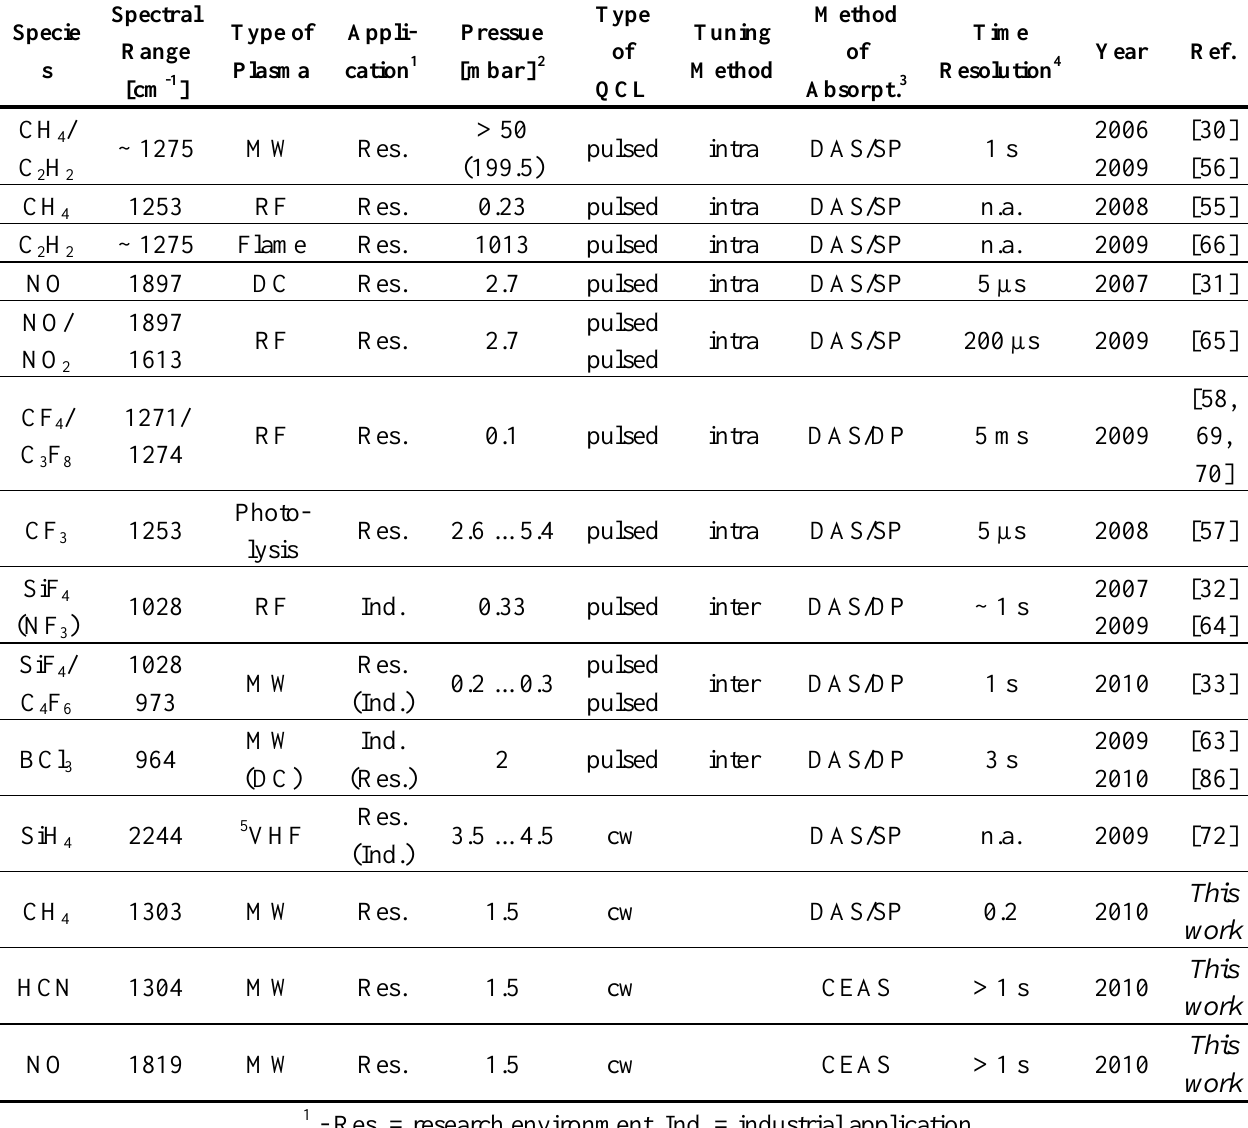
Table 2. Tabulation of plasma diagnostic applications of mid-IR